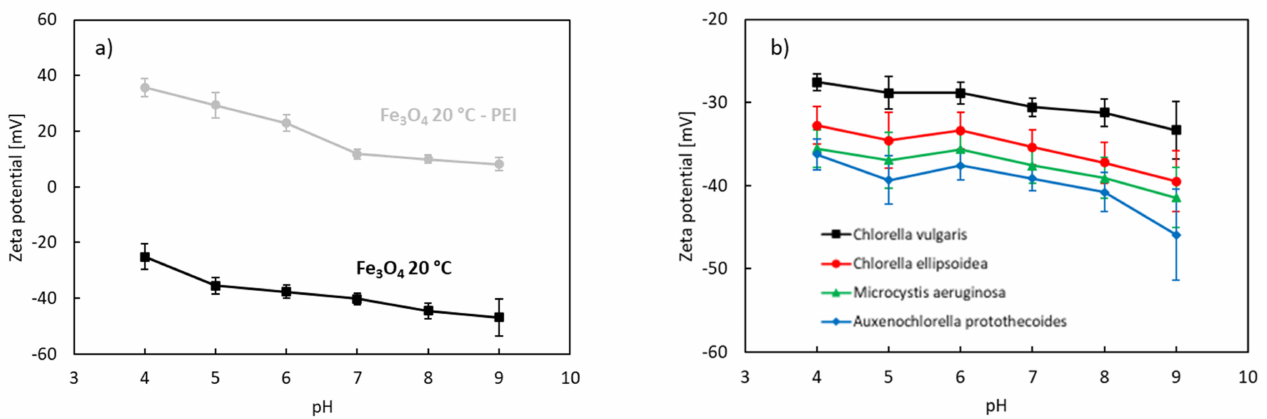
Figure 6. Zeta potential of naked and PEI-coated Fe3O4 NPs prepared at 20 ◦ C ( a ) and microalgae species ( b ). Standard deviations are